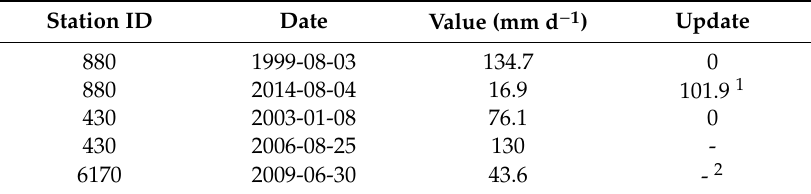
Table A1. High-resolution data revised by DWD, station id according to Table 1.